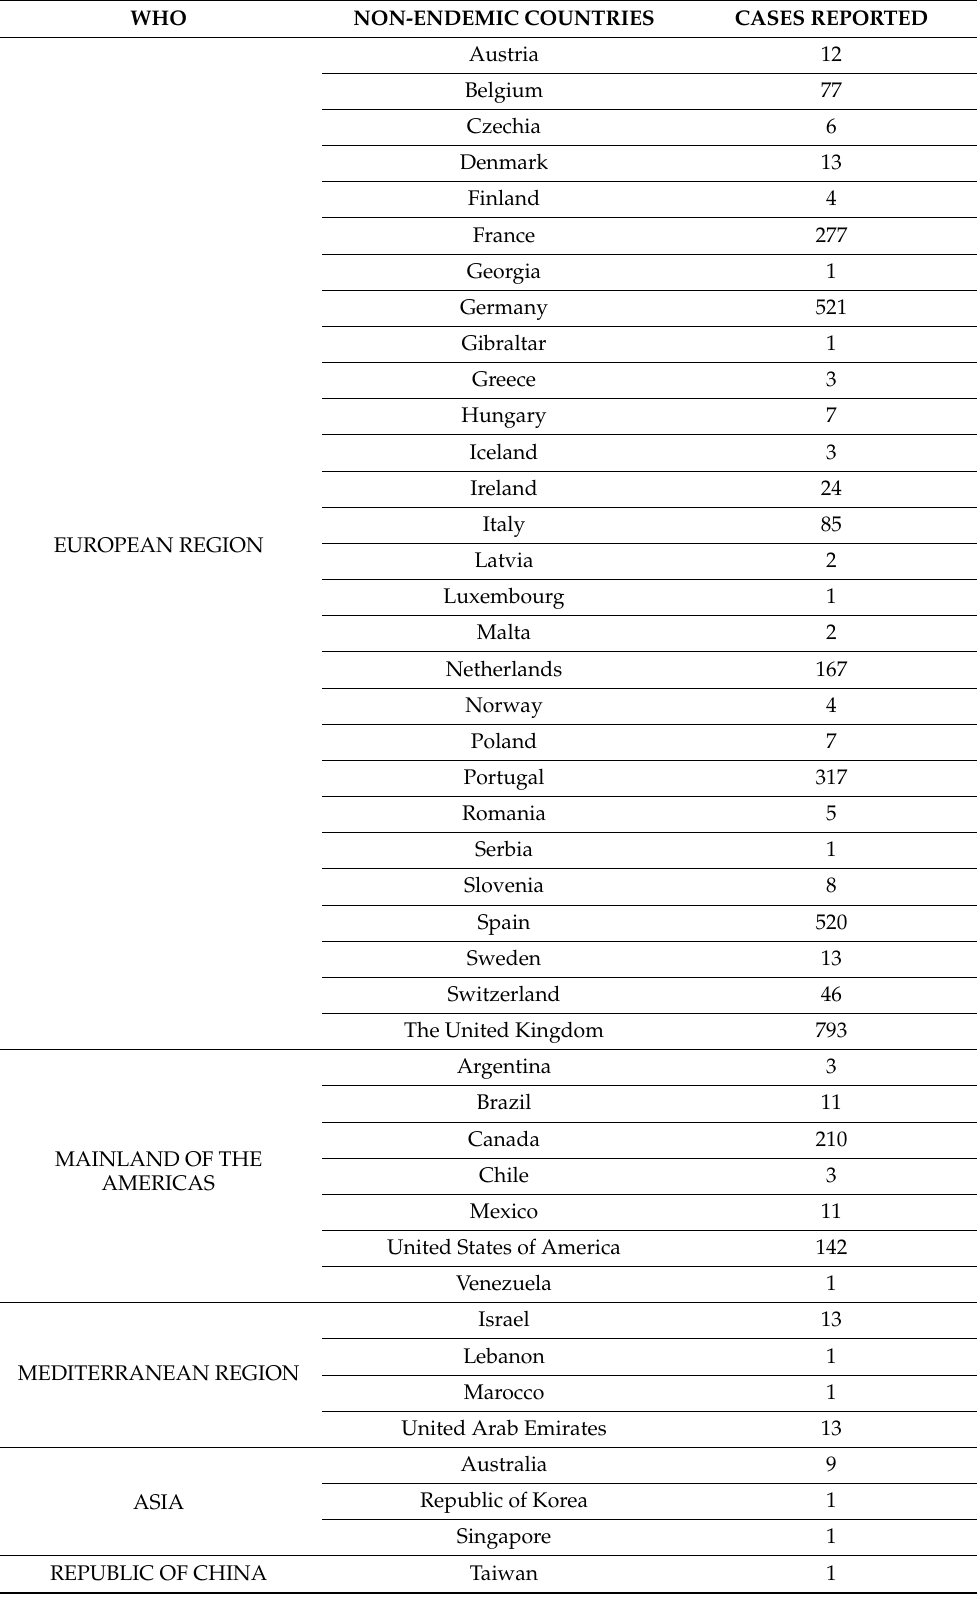
Table 1. The number of cumulative confirmed monkeypox cases reported to the WHO, in non- endemic Regions, from 1 January 2022 to July